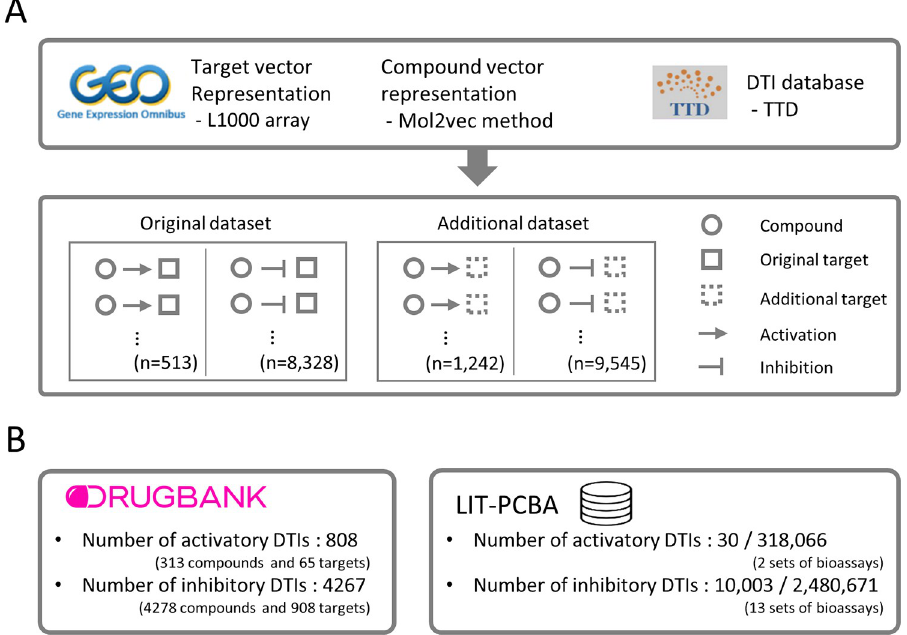
Fig 3. Construction of a dataset of known DTIs and features. (A) Training dataset construction. Transcriptome profiles were obtained from the L1000 array data and then aggregated to generate a representative target vector. A mol2vec method was used to generate representative vectors for compounds. DTIs with modes of action were collected from the TTD. The original dataset was constructed by selecting activatory and inhibitory DTI pairs that include a compound for which ECFPs can be calculated and an original target (i.e., a target for which genetically perturbed transcriptome data are available). The additional dataset was constructed by selecting activatory and inhibitory DTI pairs that include a compound for which ECFPs can be calculated and an additional target (i.e., a target for which inferred transcriptome data are available). (B) Independent dataset construction. Two independent datasets, Drugbank and LIT-PCBA datasets, were constructed to evaluate the reliability of predictions for unseen DTI in training